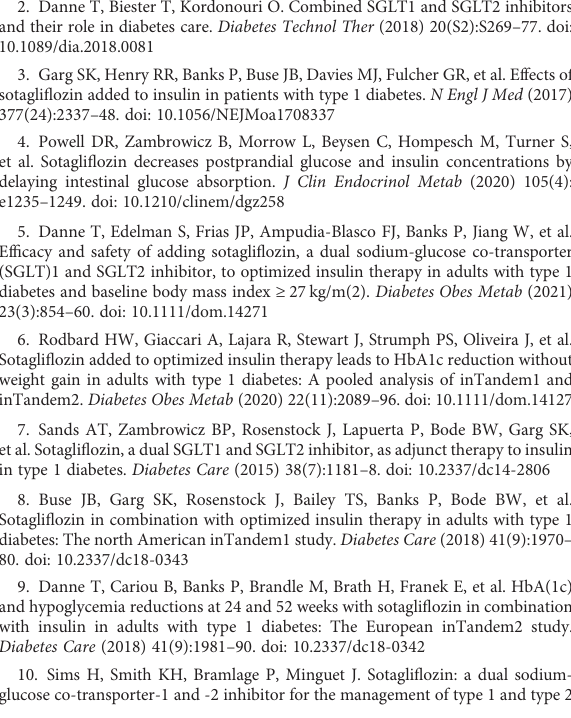
SUPPLEMENTARY FIGURE 2 Publication bias of the secondary clinical outcomes for KMC versus the control group.